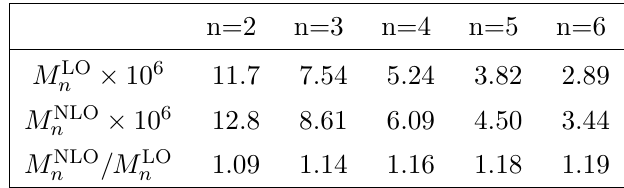
( z, µ F ) with µ F = 3 m b and b